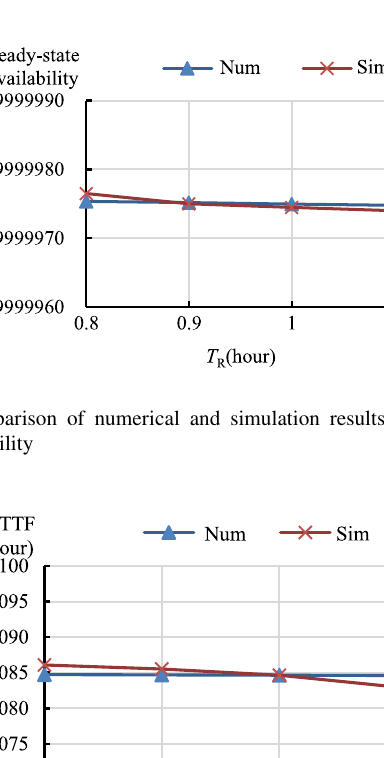
Fig. 4 Comparison of numerical and simulation results for transient availability